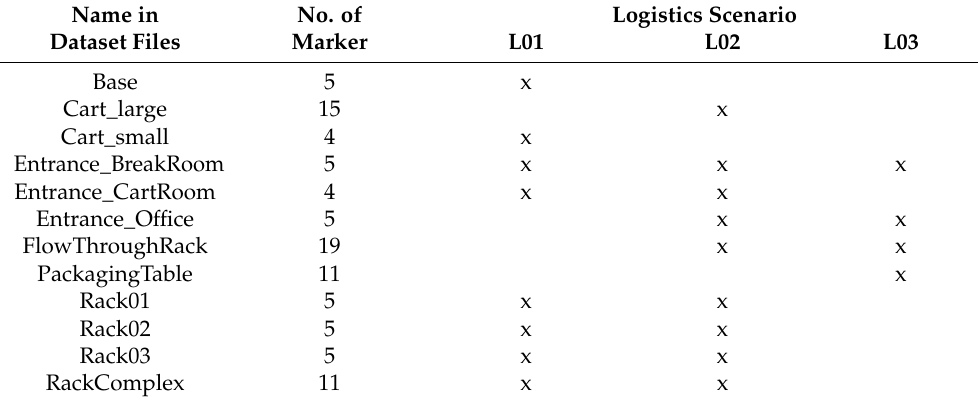
Table 2. Objects—specifications and scenario assignment.